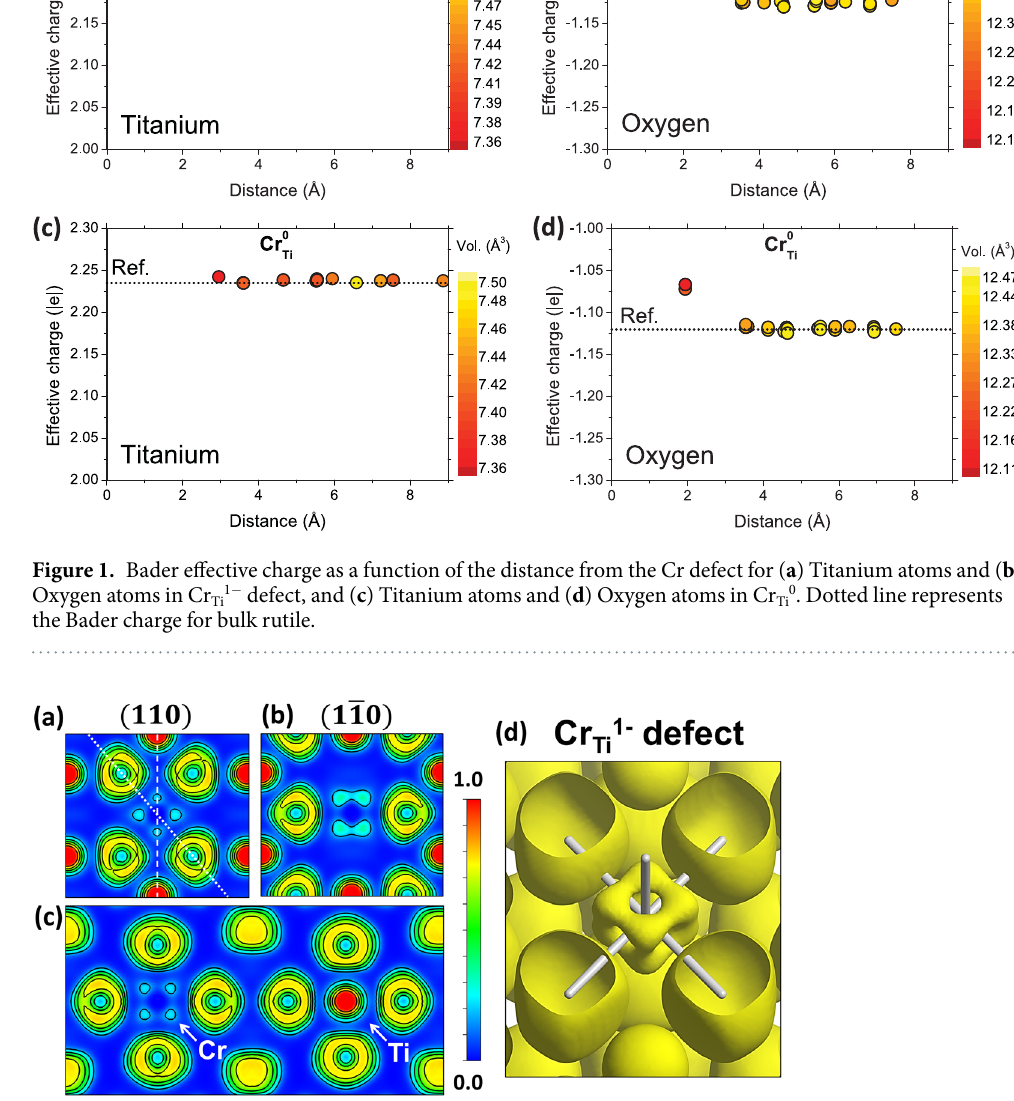
Figure 2. ELF cross section along the ( a ) (110) plane, ( b ) ( 110 ) plane and ( c ) the apical plane perpendicular to (110) for the Cr Ti1 − defect. Dotted line in (a) represents the intersection with ( 110 ) plane and dashed line represents the intersection with the apical plane. ( d ) Isosurface for an ELF = 0.15 for the Cr Ti1 − defect. Cr–O bonds are represented as white